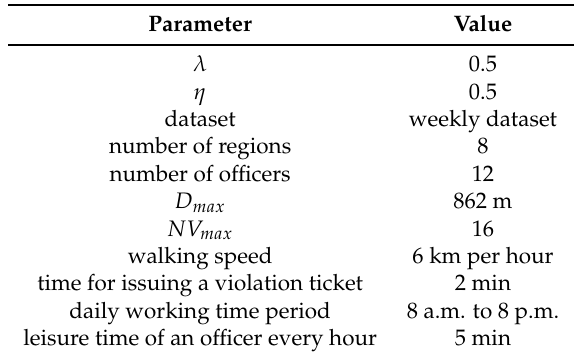
Table 1. Simulation